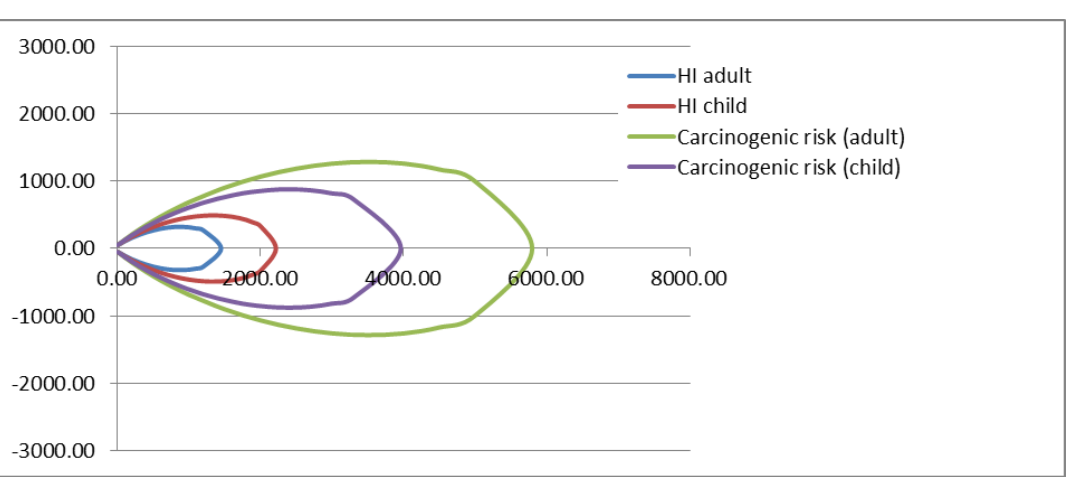
Table 5. The borders of the contaminated plume along axes x and y in the case of toxic risk for adults. x (m) y (m)